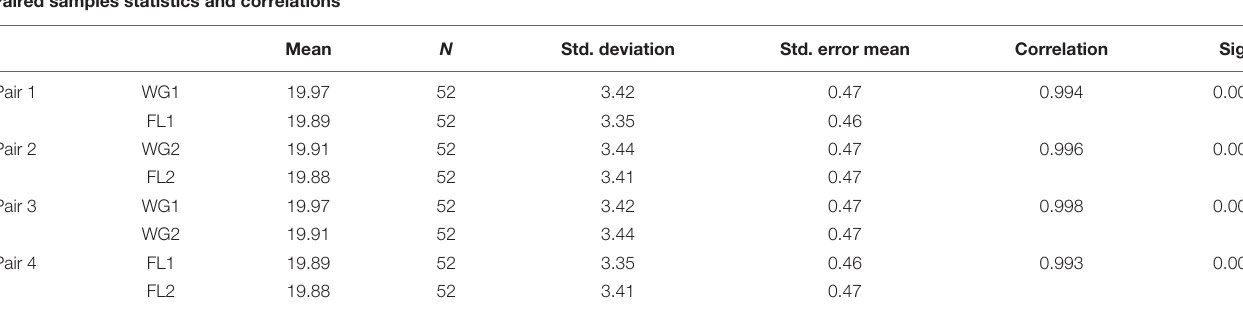
TABLE 6B | Paired sample statistics and correlations showing mean, standard deviation, and correlations. Paired samples statistics and